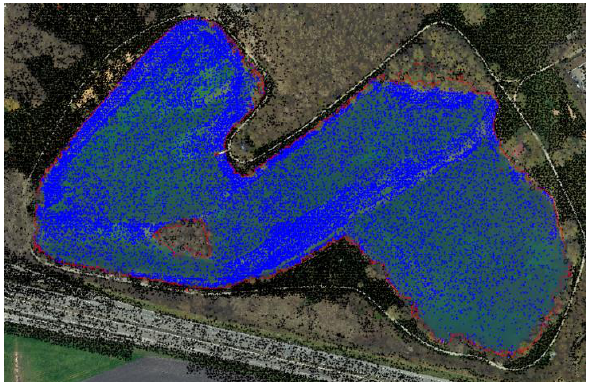
Figure 4. Matched points on land (black) and in water (blue) together with shore line (red)